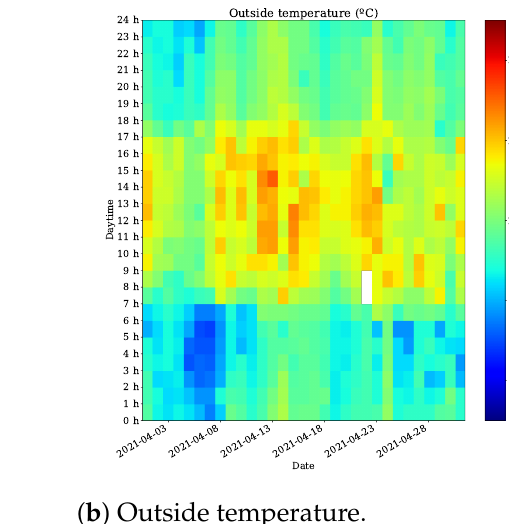
Figure 8. Temperature evolution (Apr, 2021).